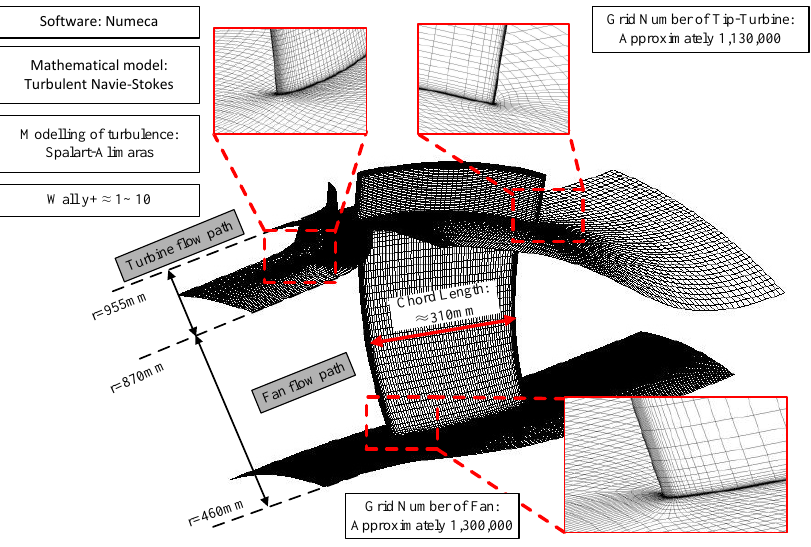
Figure 4. Medium Grid of the ADFTT Rotor (including the stator of the tip turbine).